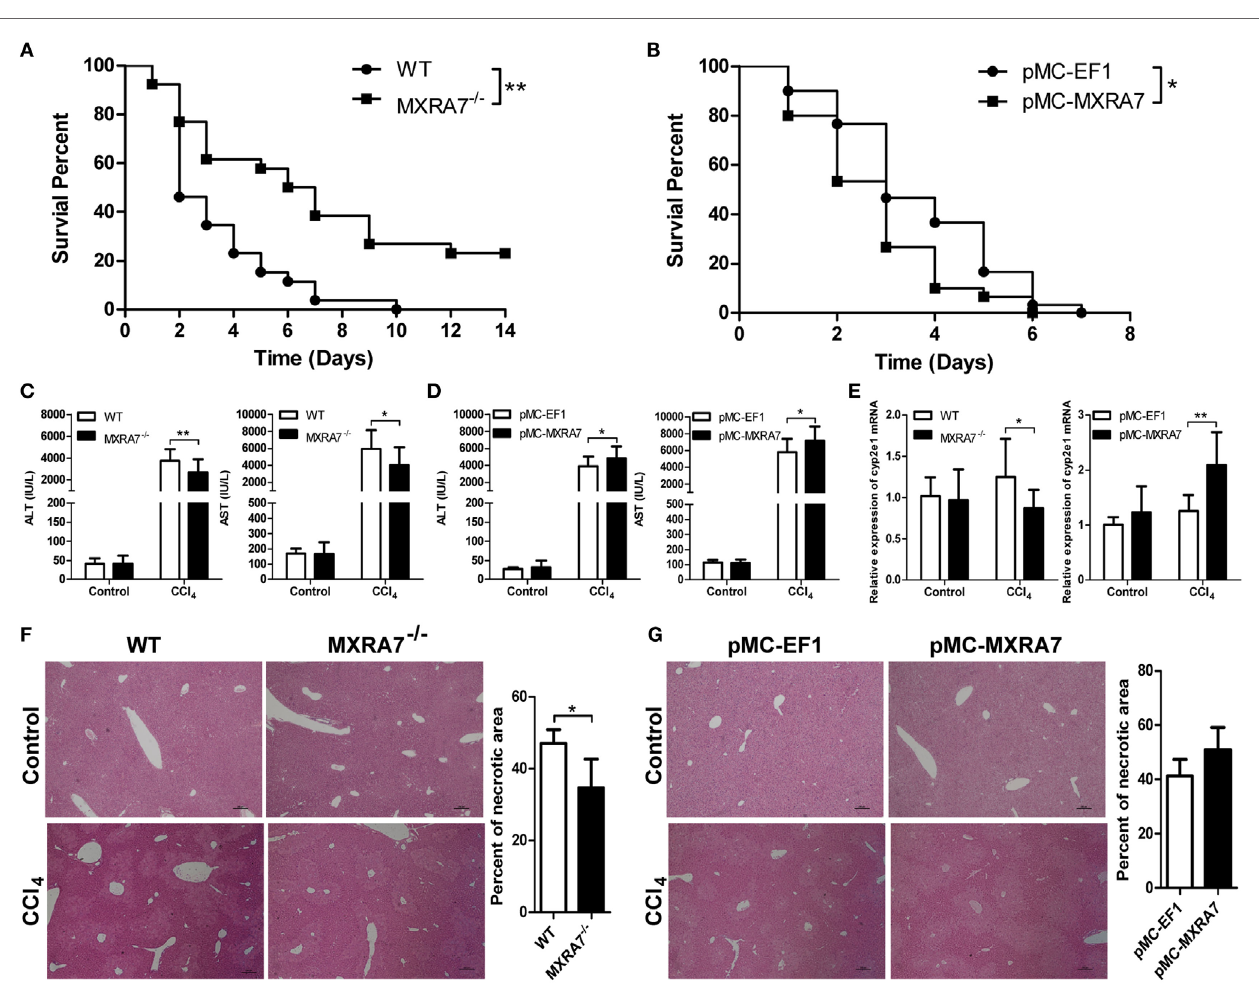
FigUre 1 | Matrix remodeling associated 7 (MXRA7) deficiency alleviates, while MXRA7 overexpression aggravates CCl 4 -induced acute liver injury. (a) Wild-type (WT) and MXRA7 − / − mice were administered intraperitoneally with 6 ml/kg CCl 4 (1:1 corn oil), and survival of animals were monitored daily for 14 days after n = 26 in each group. The data was expressed as the Kaplan–Meier survival curves and analyzed by the log-rank test. The data shown are the summary of three experiments. (B) C57BL/6 mice were injected with mock pMC-EF1 (control) or pMC-MXRA7 plasmids by hydrodynamic gene transfer method. Three days later, the animals were challenged with CCl 4 as above. Survivals were monitored once a day for 7 days after administration. n = 30 each group. The data shown are the summary of four experiments. (c–g) WT and MXRA7 − / − mice, or pMC-EF1 and pMC-MXRA7-pulsed mice, were treated with 1 ml/kg CCl 4 injection (1:1 corn oil) or control oil. Twenty four hours later, the animals ( n = 6 for control group, n = 18–23) were sacrificed and serum were harvested measurement of ALT and AST (c,D) , while livers ( n = 3 for control group, n = 9 for CCl 4 ) were harvested and subjected to measurement of CYP2E1 mRNAs using reverse transcription-quantitative real-time PCR (e) and structure evaluation after histological hematoxylin and eosin staining (F,g) . For histological evaluation, necrotic areas were determined by microscopy. The percentage of necrotic area was determined by dividing the sum area of necrosis by the sum of the total liver area of four fields. One representative section is shown for each group (original magnification: 40 × ). The data shown are the summary of three experiments. * p < 0.05, ** p <